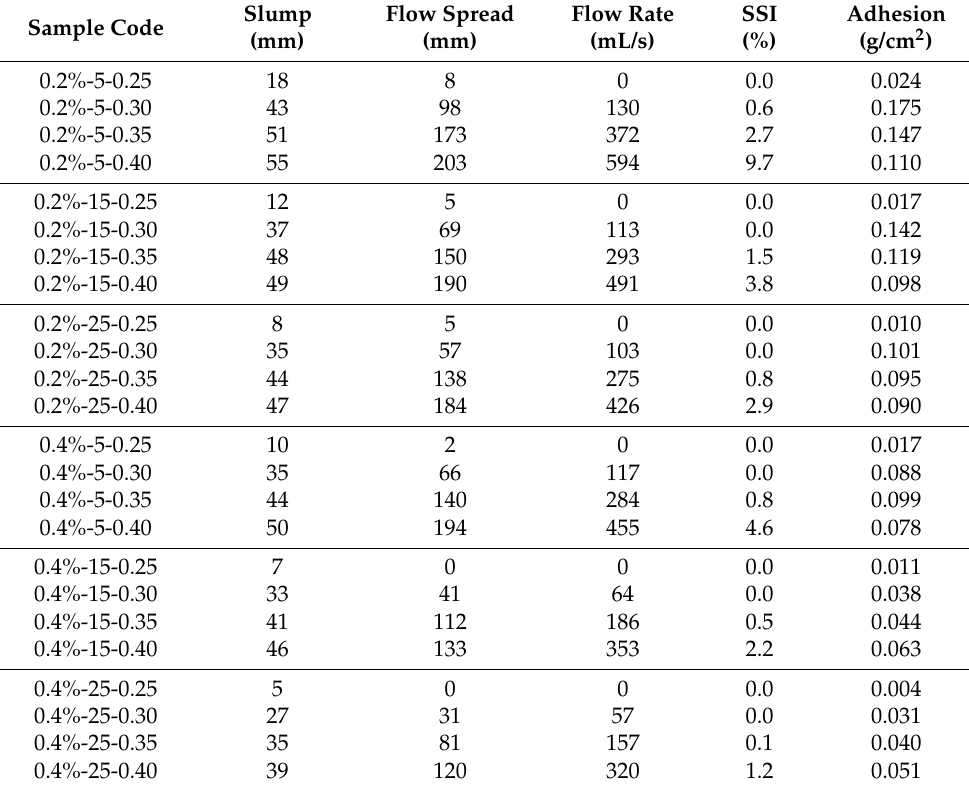
Table 5. Test results of mortar samples with varying fibre dosage and varying